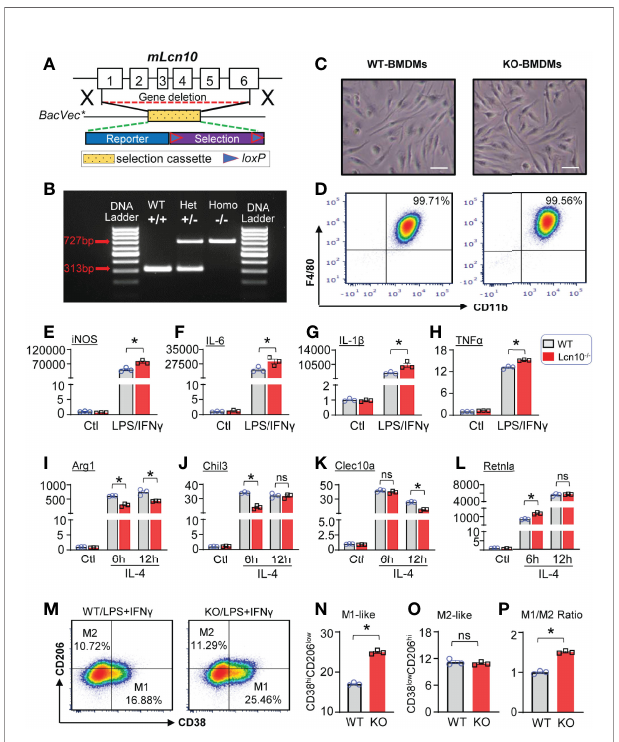
FIGURE 2 | Lcn10 de fi ciency skews macrophages towards a pro-in fl ammatory phenotype. (A, B) Generation of the knockout mouse model of Lcn10. Genetic deletion of Lcn10 (A) and genotyping result (B) . (C, D) BMDMs from WT and Lcn10-KO mice were cultured and allowed to differentiate for 7days in vitro . Representative images of mature BMDMs morphology (C) and fl ow cytometry plots of mature macrophage markers (D) from WT and Lcn10-KO mice (Scale bar, 10µm). (E – L) Gene expression levels of pro-in fl ammatory marker genes (iNOS, IL-6, IL-1 b , TNF a ) (E – H) or anti-in fl ammatory marker genes (Arg1, Chil3, Clec10a, Retnla) (I – L) as measured by qRT-PCR in BMDMs from WT and Lcn10- KO mice stimulated with LPS (10 ng/ml) + IFN- g (10 ng/ml) for 6 hours (E – H) or IL-4 (20 ng/ml) (I – L) for 6 and 12 hours, respectively (* P < 0.05, n = 3 samples per group). (M – P) Representative fl ow cytometry plots showing M1-like (CD38 hi CD206 low ) and M2-like (CD38 low CD206 hi ) (M) populations in BMDMs and quanti fi cation of M1-like macrophages (N) , M2-like macrophages (O) , and M1/M2 ratio (P) at 6 hours after LPS (10 ng/ml) +IFN- g (10 ng/ml) treatment (* P < 0.05, n = 3 samples per group). All data are presented as mean ± SEM and analyzed by two-way ANOVA (E – L) or student ’ s t-test (N – P) ns, non signi fi insulin tolerance test compared with WT-T2D controls ( Figure 3E ). Importantly, this effect is independent of body weight gain, indicating that metabolic stress induced by HFD feeding and STZ injection was required for Lcn10 to in fl uence metabolic hemostasis. Lastly, we assessed cardiac function at 8 weeks post-STZ injection using echocardiography. We found that Lcn10-KO mice exhibited normal cardiac function compared with WT controls under chow diet feeding ( Figures 3F, G ). However, compared to WT-T2D mice, KO-T2D mice showed a reduced cardiac contractile function, as evidenced by a 20% reduction in fractional shortening ( Figures 3F, G ). Collectively, these data demonstrate that Lcn10 de fi ciency leads to aggravated insulin resistance and cardiac dysfunction under diabetic conditions.